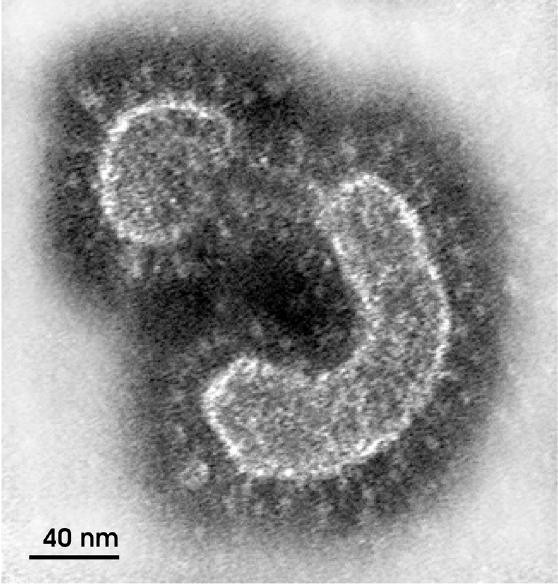
Figure 1. Electron micrograph of a coronavirus particle obtained by negative staining of a clarified suspension of a human fecal sample (Source: Monika Barth/IOC) [3].